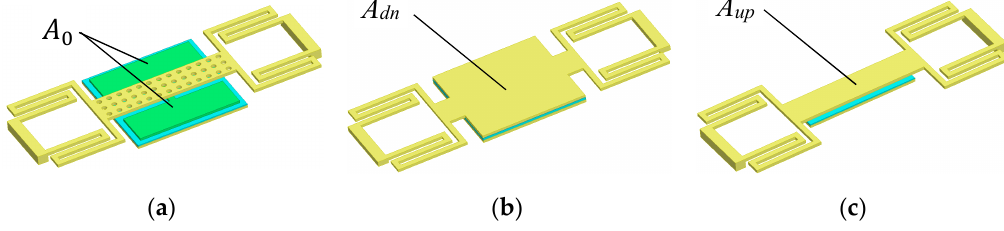
Figure 3. Models of the proposed switch. ( a ) 3D model; ( b ) Equivalent model of down state; ( c ) Equivalent model of up state (some details were neglected for simplification).